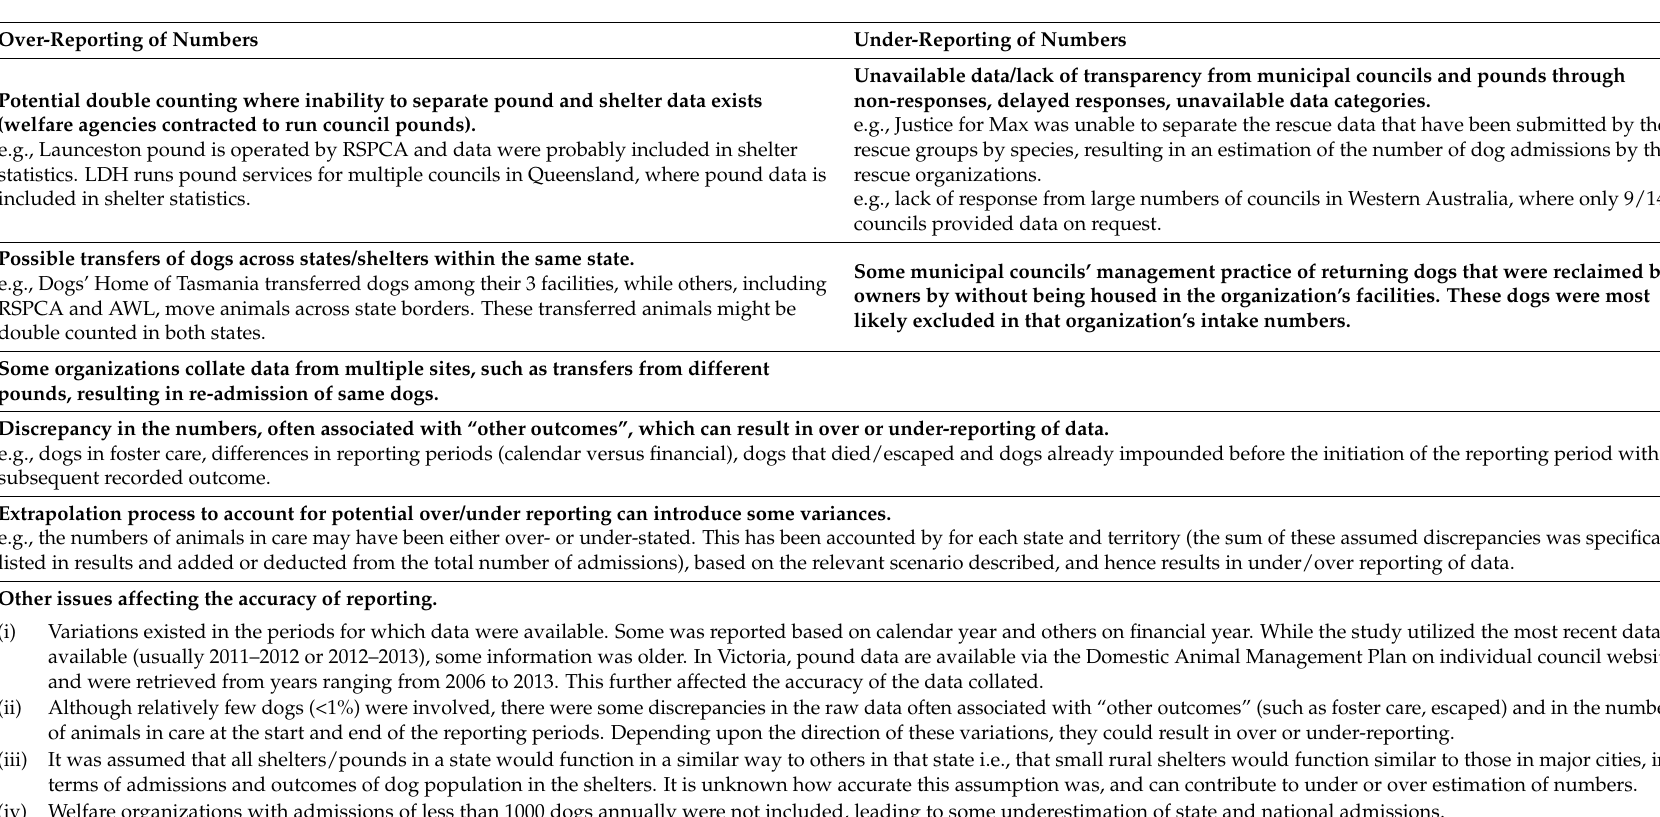
Table A2. Limitations of the study: issues resulting in over/under reporting of